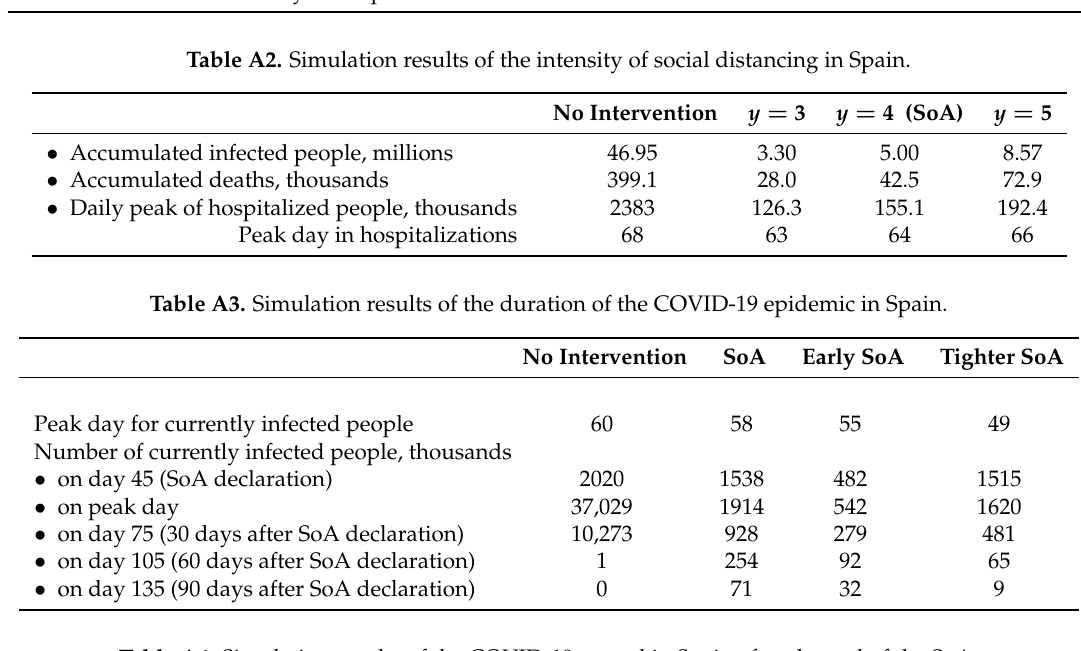
Table A4. Simulation results of the COVID-19 spread in Spain after the end of the SoA. α y = 0.10 α y = 0.08 α y =